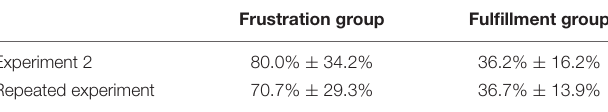
TABLE 7 | Level of altruistic behavior (Mean and SD ) by